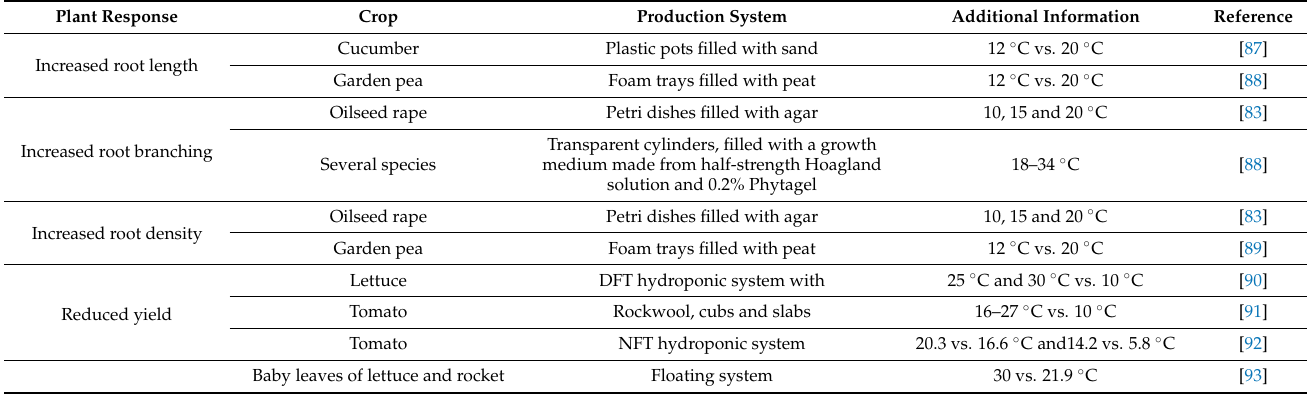
Table 4. Plant responses to rootzone